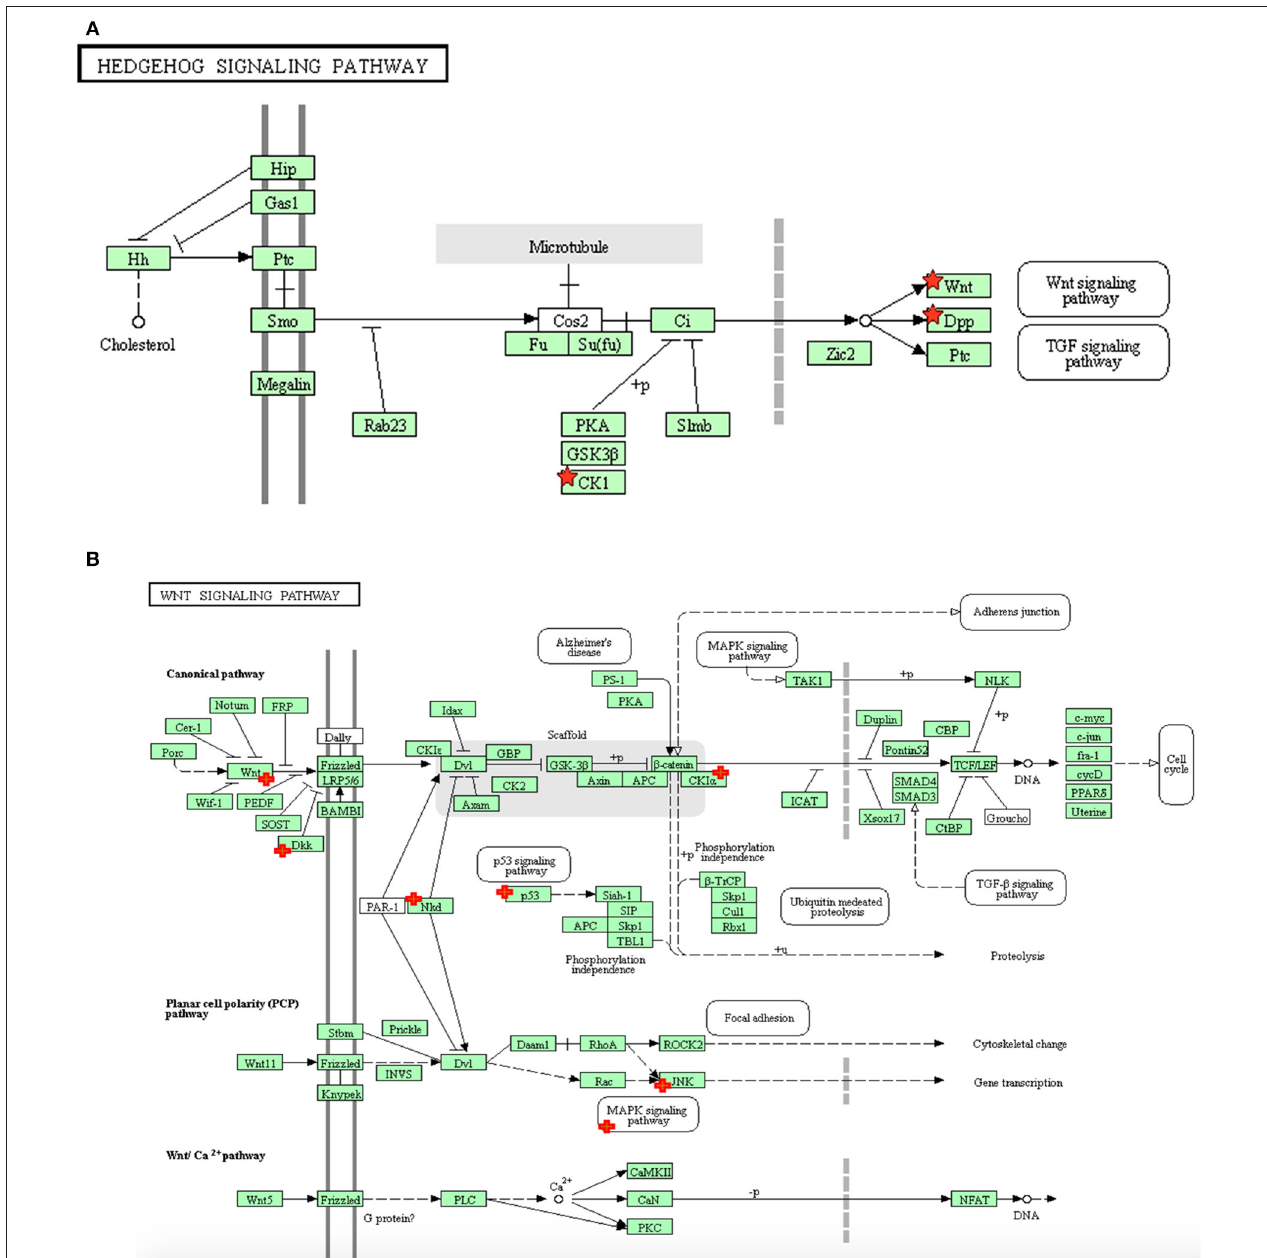
FIGURE 2 | The distribution of differentially expressed genes in astrocytes following hypoxia + hypothermia vs. hypoxia: (A) Within the Hedgehog signaling pathway, (B) Within the Wnt signaling pathway in primary human cortical astrocytes being cultured under hypoxic conditions (5% O 2 ) for 6h with or without hypothermic intervention (32 ◦ C after 2h; maintaining hypoxia for 6h) (adapted from KEGG website: www.genome.jp/kegg). The significant up- and down-regulated genes, indicated with red + signs, were identified using DAVID/KEGG enrichment analysis of microarray data ( n = 2). X (Bax) ( P = 0.023), Bcl-2-like protein 1 (Bcl-x) ( P = 0.029), claspin ( p = 0.03), Fas-associated protein with death domain (FADD) ( P = 0.034), HIF-1 α ( P = 0.023), Heat shock proteins [HSP; including HSP32 ( P = 0.006), HSP27 ( P = 0.042), HSP70 ( P = 0.006)], Serine protease HTRA2 (HTRA2) ( P = 0.039) and Cyclin Dependent Kinase Inhibitor 1B (CDKN1B) ( P = 0.04) transcript expression level. While there was no